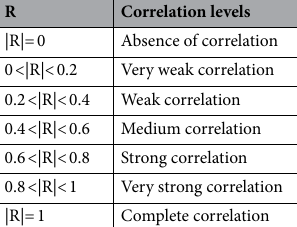
Table 2. The Pearson correlation coefficient value (R) and corresponding correlation